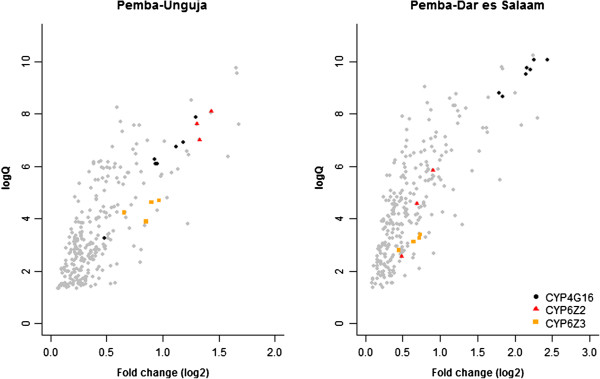
Volcano plots for expression between An. arabiensis from Pemba against samples from Dar es Salaam and Unguja. Expression plots for the 268 candidate probes significantly up-regulated in (i) An. arabiensis from Pemba collected in 2012 against UNG and (ii) DAR. Probes for the three candidate P450s are highlighted on each plot.